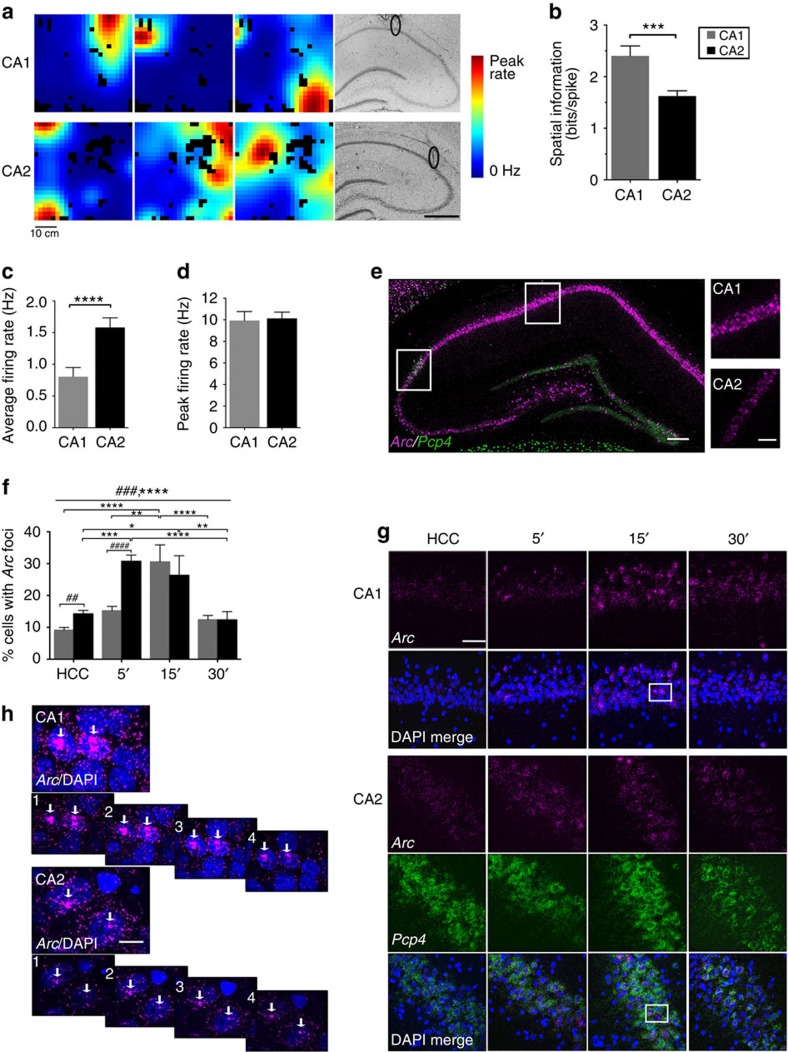
CA2 encodes spatial information.(a) Place field maps for three neurons and electrode tracks for CA1 and CA2. (b) Spatial information calculated for CA1 and CA2 neurons. CA2 neurons carried less spatial information than CA1 neurons (median(CA1)=2.191, median(CA2)=1.536, U=741, P<0.001, Mann–Whitney test, n=61 CA2 neurons and 31 CA1 neurons). (c) CA2 place cells had a higher average firing rate than CA1 place cells (median (CA1)=0.5146, median(CA2)=1.354, U=468, P<0.0001, Mann–Whitney test, n=61 CA2 neurons and 31 CA1 neurons). (d) CA1 and CA2 place cells had similar peak firing rates (median(CA1)=9, median(CA2)=9, U=860, P>0.05, Mann–Whitney test, n=61 CA2 neurons and 31 CA1 neurons). (e) Representative smFISH probing for Arc and Pcp4 in dorsal hippocampus from a rat that was killed 30 min after a 10-min exploration. (f) Time course of the percentage of cells with Arc foci in CA1 and CA2 following spatial exploration (main effect of time F(3,25)=11.09, P<0.0001; main effect of subregion F(1,25)=19.47, P<0.001, two-way paired ANOVA with Bonferroni post hoc tests denoted on graph; n=5–9 rats per condition). (g) Representative images of data in f. (h) High-magnification images of neurons outlined by white boxes in g. Arrows denote Arc foci throughout z-plane. HCC, home cage controls. Scale bar, 500 μm (a), 200 μm (e, left image), 50 μm (e, right image and g), 10 μm (h). *P<0.05; **P<0.01; ***P<0.001, ****P<0.0001. Error bars are s.e.m.